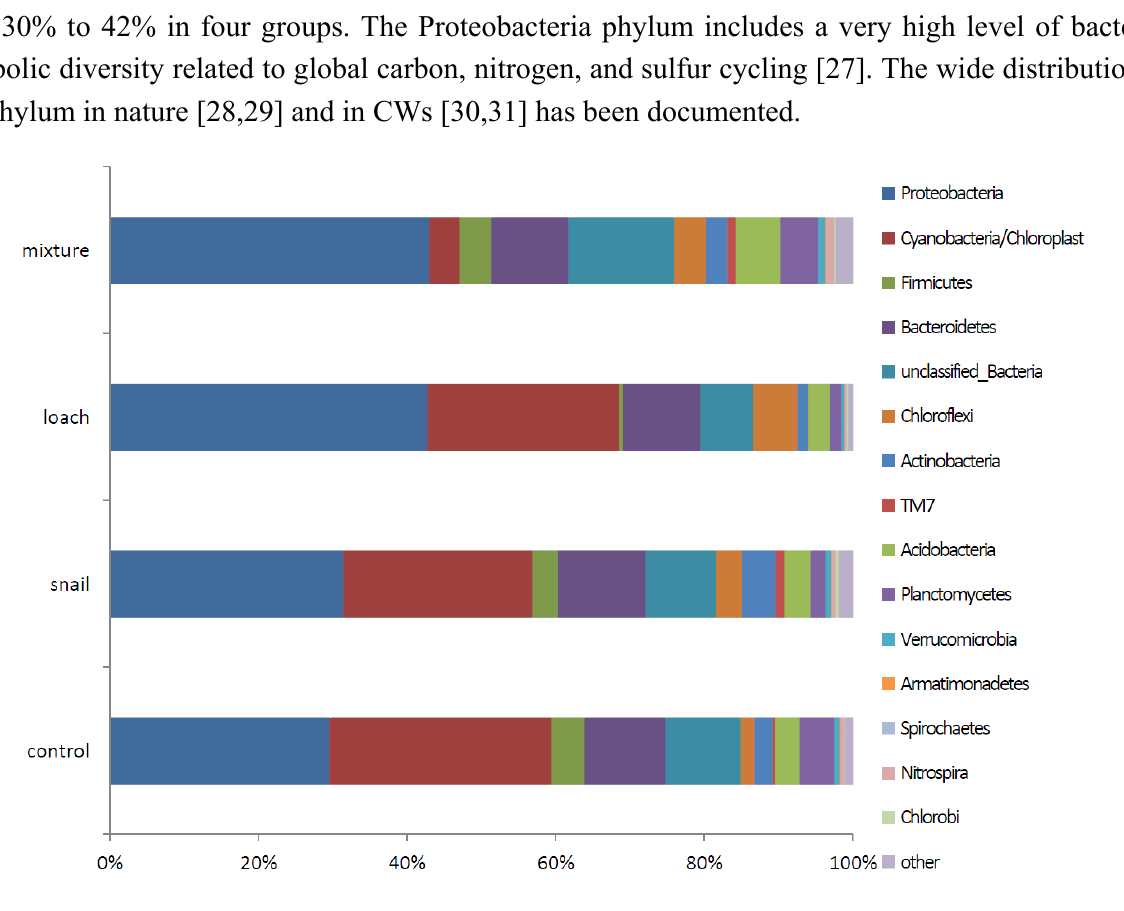
Figure 5. Abundances of the bacterial phylogenic